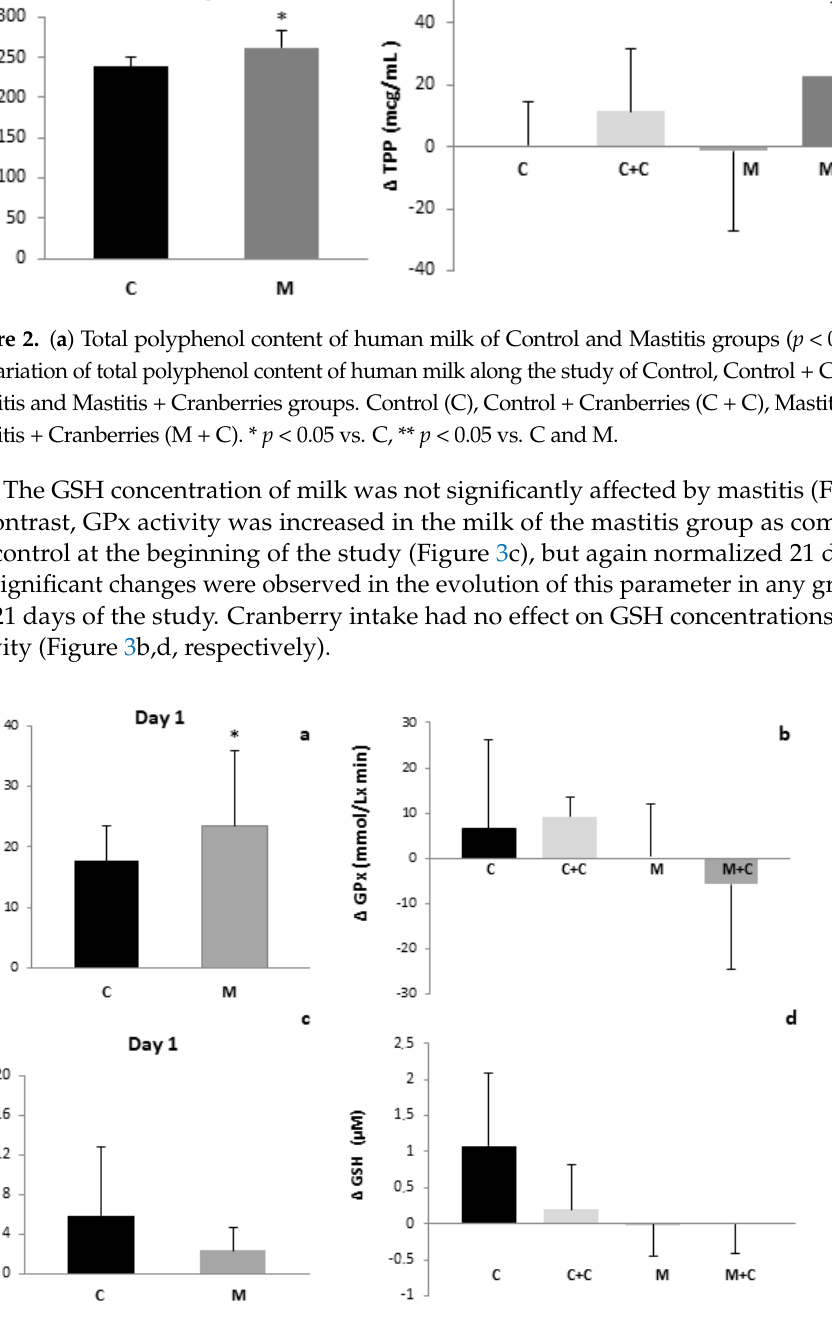
Figure 3. ( a ). GPx activity of human milk of Control and Mastitis groups ( p < 0.05 vs. C). ( b ). Variation of GPx activity of human milk along the study of Control, Control + Cranberries, Mastitis and Mastitis + Cranberries groups. * p < 0.05 vs. C. ( c ). GSH concentration of human milk of Control and Mastitis groups ( p < 0.05 vs. C). ( d ). Variation of GSH concentration of human milk along the study of Control, Control + Cranberries, Mastitis and Mastitis + Cranberries groups. Control (C), Control + Cranberries (C + C), Mastitis (M) and Mastitis + Cranberries (M + C). * p < 0.05 vs.